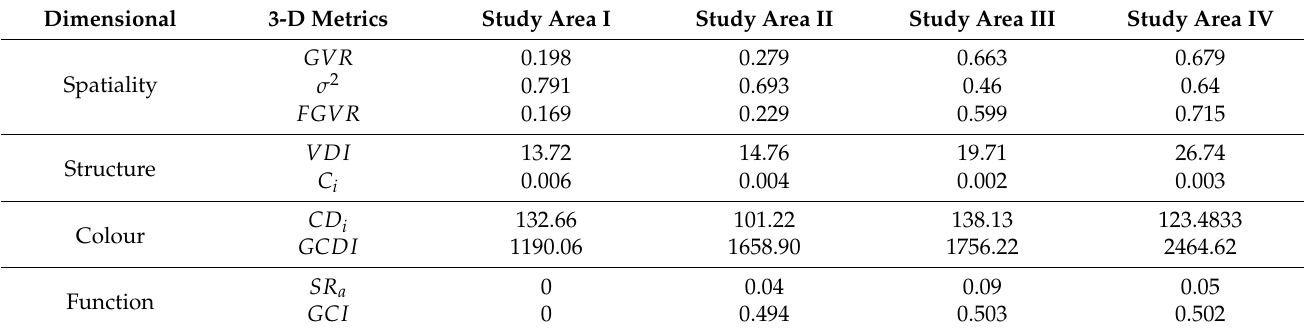
Table 3. Performance of the 3-D assessment metrics in the study